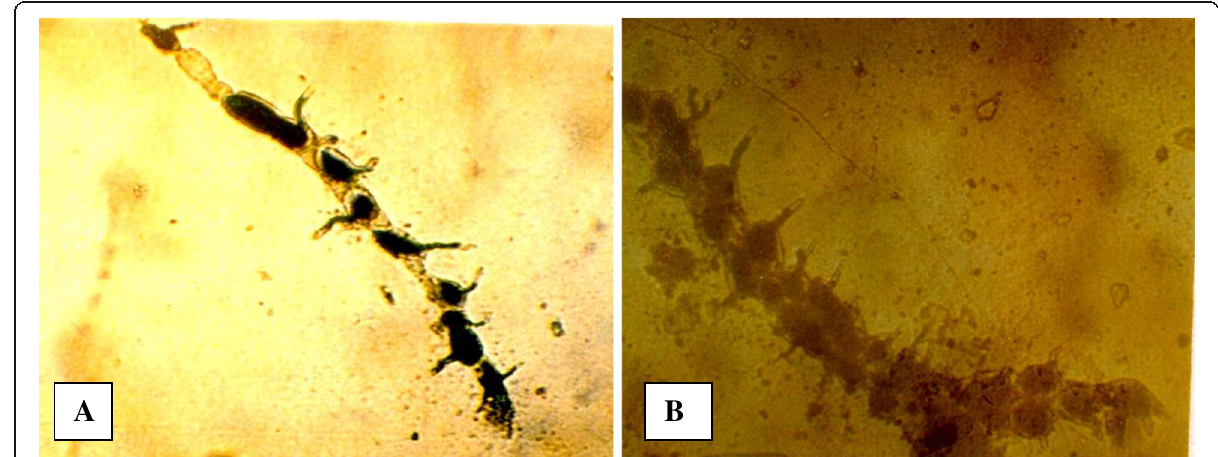
Fig. 2 Catenaria anguillulae . a Chain of mature and immature sporangium. b Double chain of mature and immature sporangium on nematode